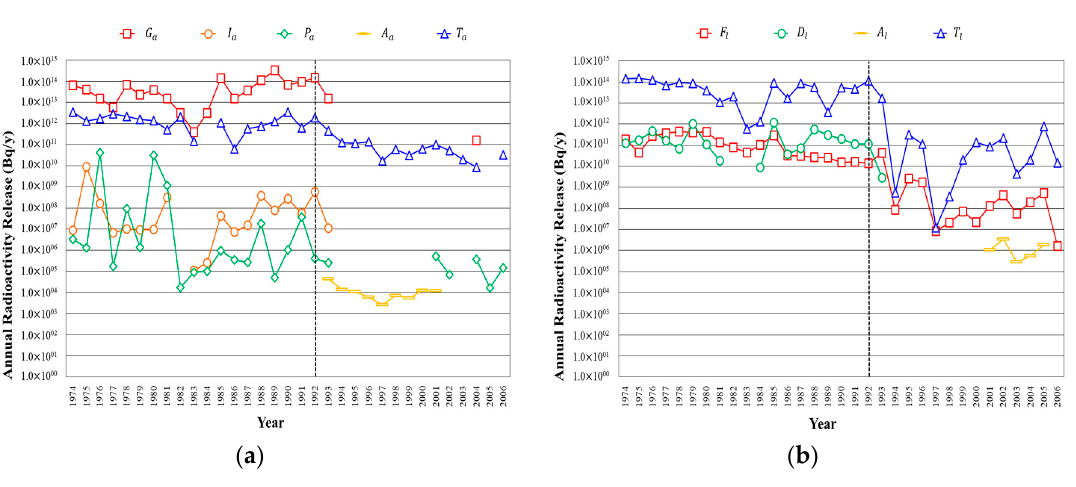
Figure 8. Annual trends of radioactive materials released from San Onofre-1 from 1974 to 2006: ( a ) Airborne e ffl uent; ( b ) Liquid e ffl uent [48]. The dotted line indicates the year of permanent shutdown.